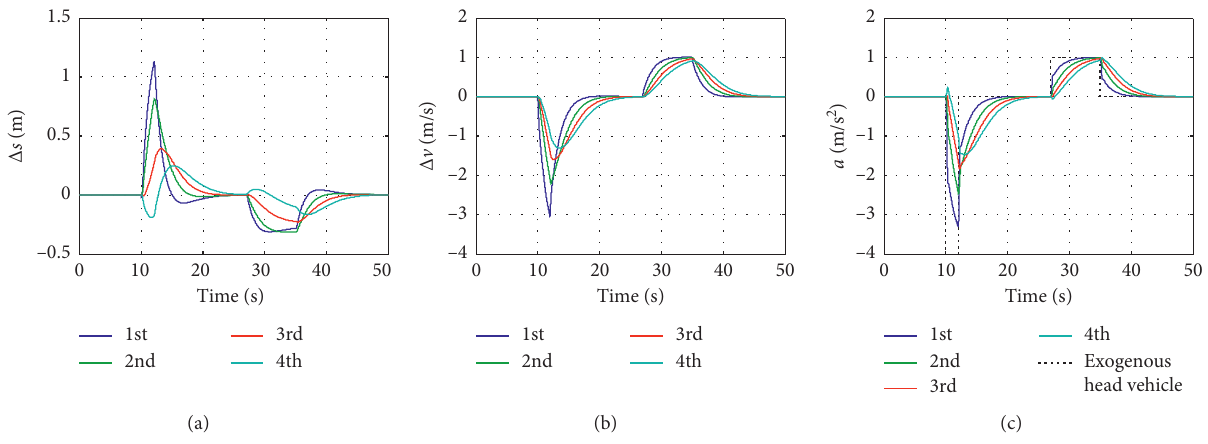
Figure 6: Simulation result of CTG-IPSO: (a) gap error, (b) relative speed, and (c) actual acceleration.